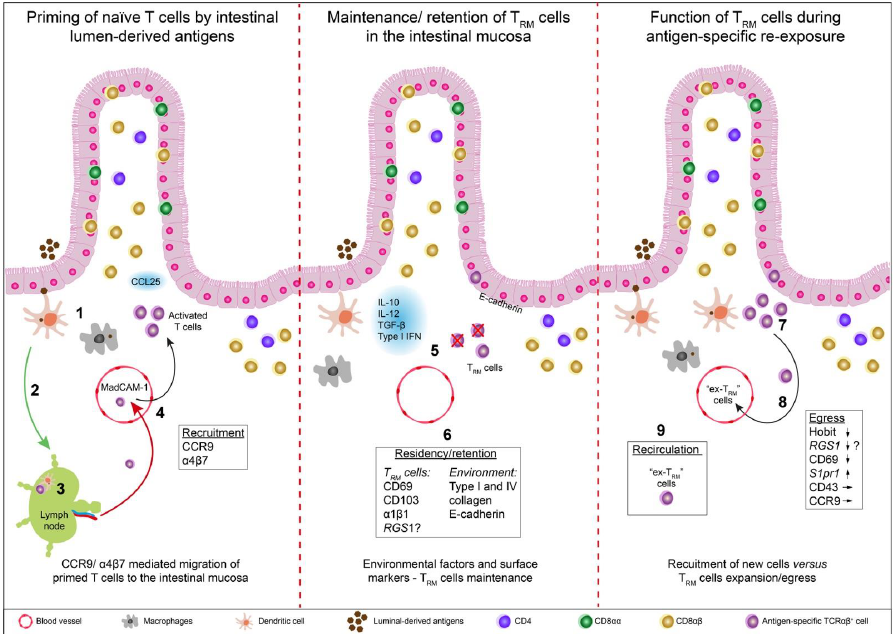
Figure 1. Activation of conventional intestinal T cells following primary exposure to a novel, MHC-restricted antigen versus re-exposure of T RM cells to their cognate antigen. ( 1 ) Intestinal lumen-derived antigens (microbiota, food antigens, pathogens) breach the intestinal epithelial barrier through specialized M cells overlying intestinal Peyer’s patches and solitary follicles (not shown), or obtain access to the intestinal lamina propria when the integrity of the epithelial layer is disrupted. Inside the lamina propria, antigens are rapidly taken up and digested by local macrophages, which are rather poor antigen-presenting cells. A fraction of the intestinal lumen-derived antigens, however, is sampled by intestinal dendritic cells. ( 2 ) These antigen-loaded dendritic cells become activated and migrate to the draining mesenteric lymph nodes, ( 3 ) where they present the antigen in an MHC-restricted manner to antigen-specific naïve CCR7 + CD62L + T cells. ( 4 ) Upon their priming in the draining lymph nodes, these activated T cells acquire a gut homing phenotype, characterized by the cell surface expression of α 4 β 7 and CCR9, which bind to MadCAM-1 expressed on gut-associated endothelial cells, and to the chemokine CCL25, secreted by endothelial cells in the small intestine and by follicle-associated epithelium of Peyer’s patches, respectively. This imprinted phenotype allows the primed T cells to home back to the site of initial antigen breaching. ( 5 ) Under the influence of the local intestinal microenvironment (e.g., TGF- β , IL-12 and type-I IFN), some of these recently activated T cells acquire a T RM cell signature. ( 6 ) Within the intestinal mucosa, transcription of the α 4 chain gene is suppressed in T cells. TGF- β , secreted by macrophages and dendritic cells, induces the expression of α E integrin (CD103). The α E β 7 heterodimer binds to E-cadherin, which is expressed on epithelial cells and subsets of dendritic cells. Subsets of CD8 + T RM cells also express the integrin α 1 chain together with the β 1 integrin ( α 1 β 1), which directly binds to type I and IV collagen and, hence, supports the adherence and retention of T RM cells in skin, lung and intestine. Most T RM cells also express CD69, which antagonizes S1P 1 (Sphingosine 1 phosphate receptor-1), thus contributing to their retention within the tissue. RGS1, which attenuates signaling via G α i- or G α q- linked G-protein-coupled receptors, is also highly expressed in T RM cells. This signature allows them to remain at this site even upon complete clearance of their cognate antigen. These newly generated T RM cells will thus continuously expand the existing repertoire of antigen specificities of the local T RM cells. Some of these activated T RM cells (mostly CD8 αβ + TCR αβ + , CD8 αα + TCR αβ + and TCR γδ + cells) will home to the intestinal epithelium (“intraepithelial lymphocytes”), where they are preferentially retained by the interaction of the α E β 7 integrin on their surface with epithelial cell-expressed E-cadherin. ( 7 ) Upon re-exposure to the cognate antigen, T RM cells are rapidly activated and expand locally in the mucosa. They are prone to efficiently secrete cytokines and express cell surface molecules, which may further enhance the uptake and degradation of incoming microbes or dietary compounds by local (resident) macrophages. Reactivated T RM cells may express cytotoxic effector molecules, including granzymes and perforin, or secrete chemokines that promote the recruitment of other leukocyte subsets, including monocytes, but also effector T cells. ( 8 ) Additionally they can loose some T RM cell markers and retention profile (Hobit, CD69, and potentially RGS1 ) and upregulate genes related to egress ( S1pr1 ). ( 9 ) Thus, eventually, they can re-enter the blood circulation as “ex-T RM ” cells, becoming circulating effector cells and memory T cells, thus, supporting also the systemic immune